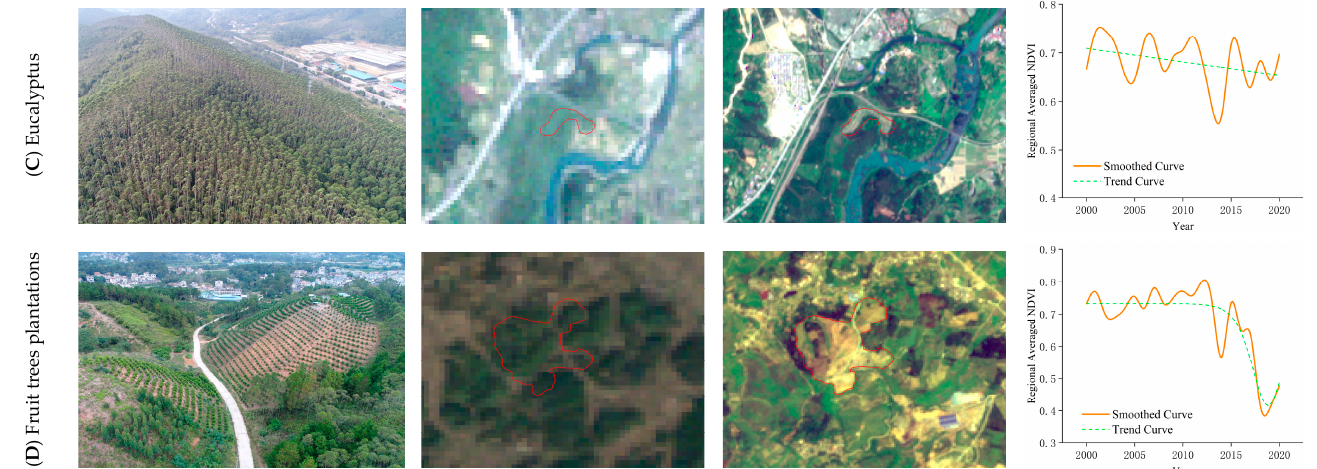
Figure 8. Cases of negative human activities. ( A ) Abandoned quarry. ( B ) Active quarry. ( C ) Eucalyptus. ( D ) Fruit trees plantations. The locations of the cases are shown in Figure 1c. The first column shows the photos taken by unmanned aerial vehicles in 2020, the 2nd and 3rd columns show the true colour Landsat-5 image of 2000 and the true colour Landsat-8 image of 2020, respectively, and the last column shows the NDVI time-series profile of each human disturbed zone.